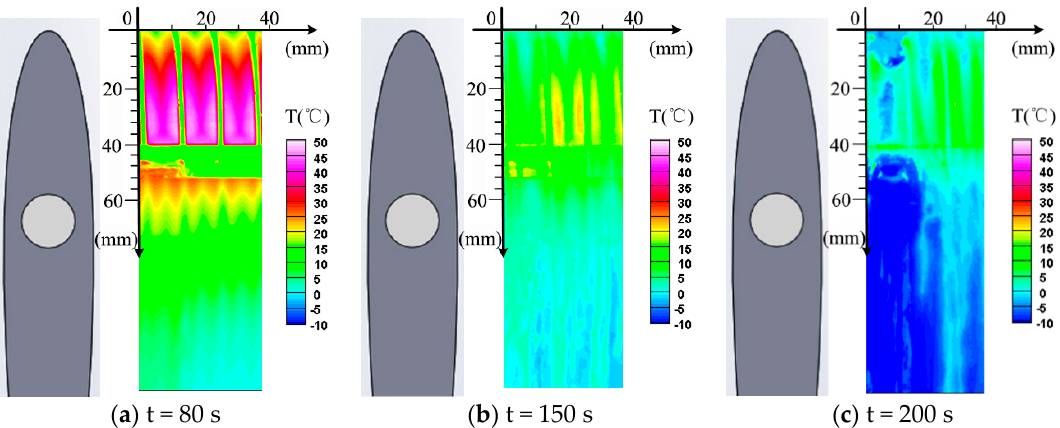
Figure 15. Time variation of the surface temperature distribution during the anti-icing process when applied with HV-LF discharge.